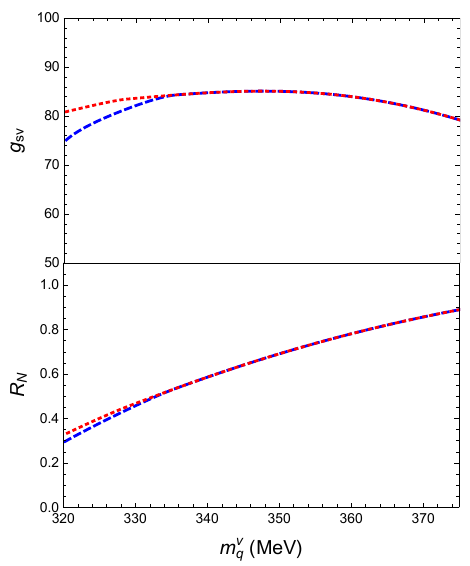
Figure 1 . The extracted values for the coupling g sv and the associated nucleon fraction R N as functions of the quark vacuum mass m v (cid:22) 0 B